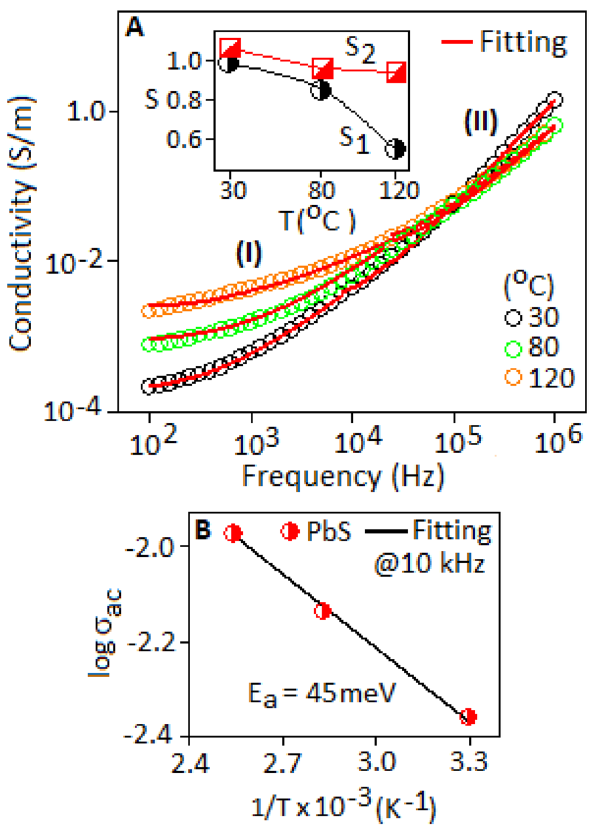
Figure 7. ( A ) AC-conductivity behaviour of the FALS based device at 30, 80 and 120 °C, measured under the frequency range from 100 Hz to 1 MHz (fitting was done according to the Jonscher’s power law, red line). The inset figure shows the variation of S 1 and S 2 parameters, extracted from the region (I) and (II), respectively. ( B ) Arrhenius plot of AC-conductivity as a function of inverse temperature (1/T), at 10